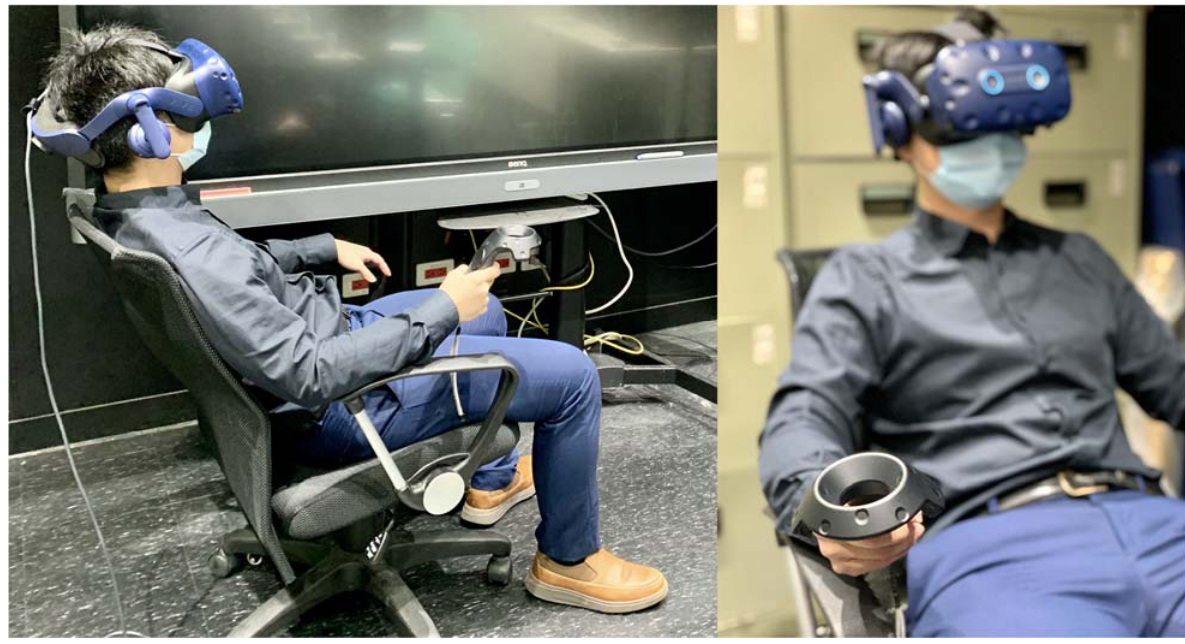
Figure 1. Demonstration of LUXIE/HTC Vive Pro Eye examination from the outside view.